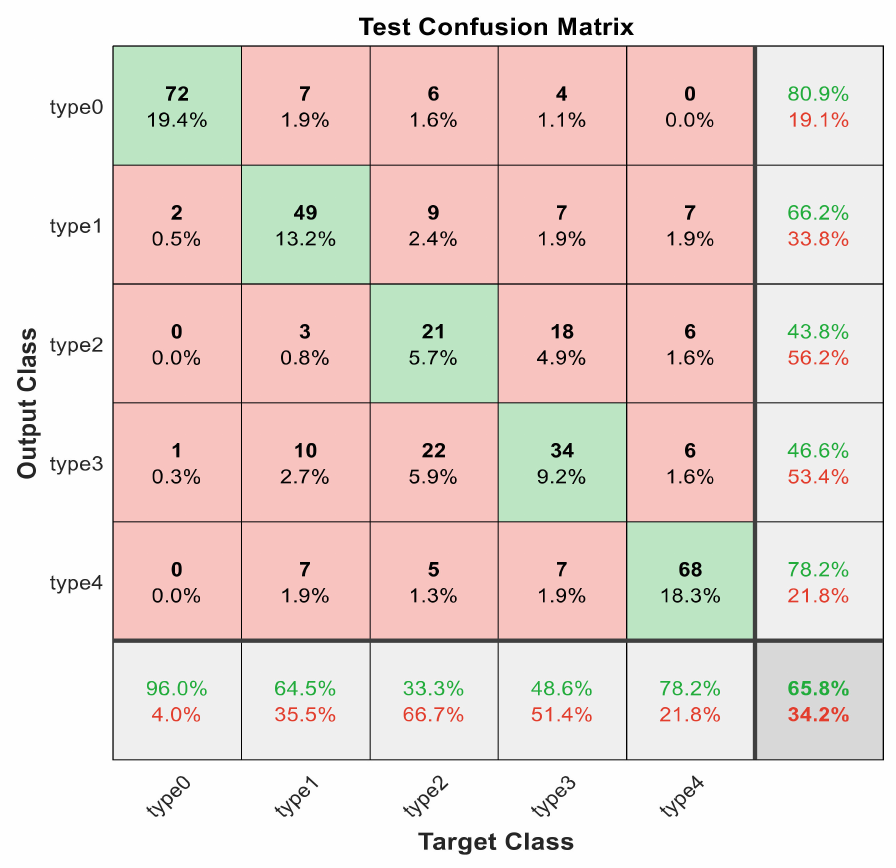
Figure 11. The confusion matrix with ECFS-reduced features for type